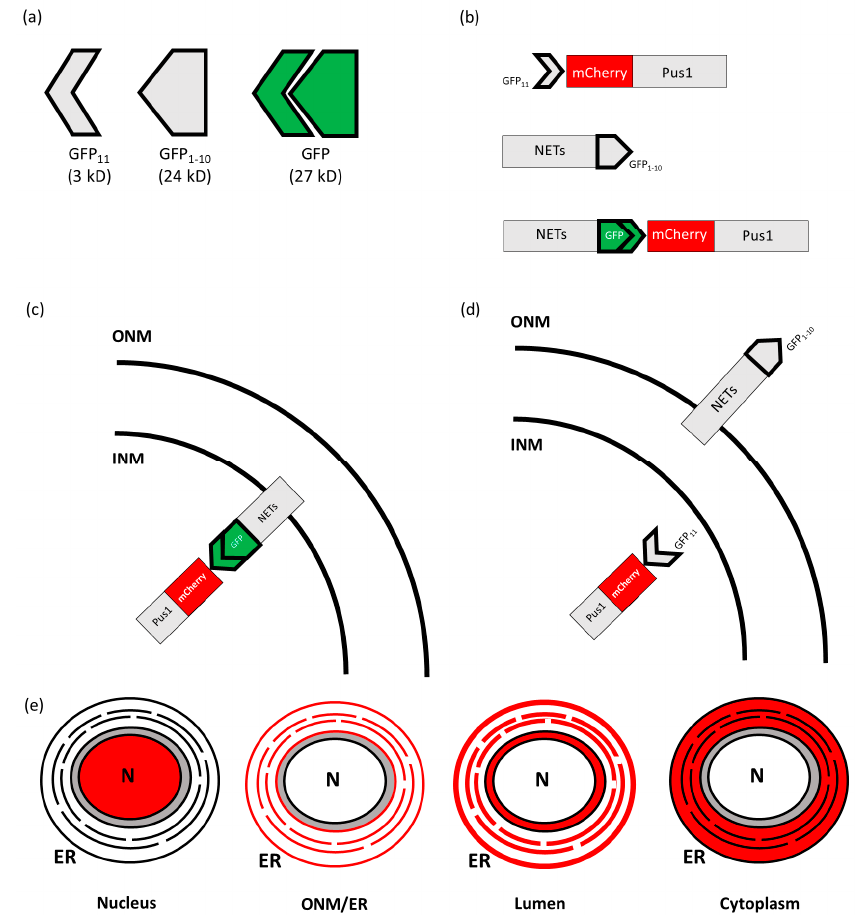
Figure 2. A conceptual representation of the split GFP system as it is used to identify the position of INM proteins: ( a ) Superfolder GFP can be split into two non-fluorescent components, which can also recombine into a fluorescently functional GFP. ( b ) A representation of the soluble nuclear yeast protein Pus1 tagged with mCherry and GFP 11 , a NET of interest tagged with the complimentary GFP 1–10 , the interaction between GFP 1–10 -tagged NET and the GFP 11 reporter resulting in green fluorescence. ( c , d ) Representations of how the localization of NETs tagged with GFP 1–10 and reporter proteins tagged with GFP 11 produce green fluorescence ( c ) or fail to do so ( d ). ( e ) A representation of control proteins tagged with mCherry and GFP 11 in the nucleus, the outer nuclear membrane (ONM) and endoplasmic reticulum (ER), the lumen, and the cytoplasm of the cell in the absence of GFP 1–10 fused NETs of interest.